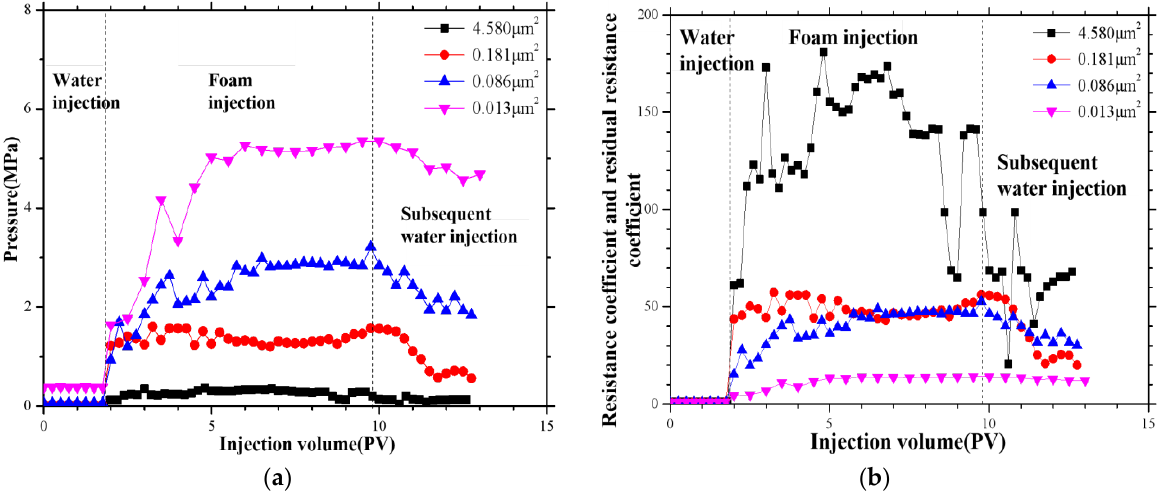
Figure 3. Foam seepage pressure difference, resistance coefficient, and residual resistance coeffi- cient under different permeability rates. (Note: ( a ) shows the variation of foam pressure difference at different permeability. ( b ) shows the change of resistance coefficient and residual resistance coefficient at different permeability.).